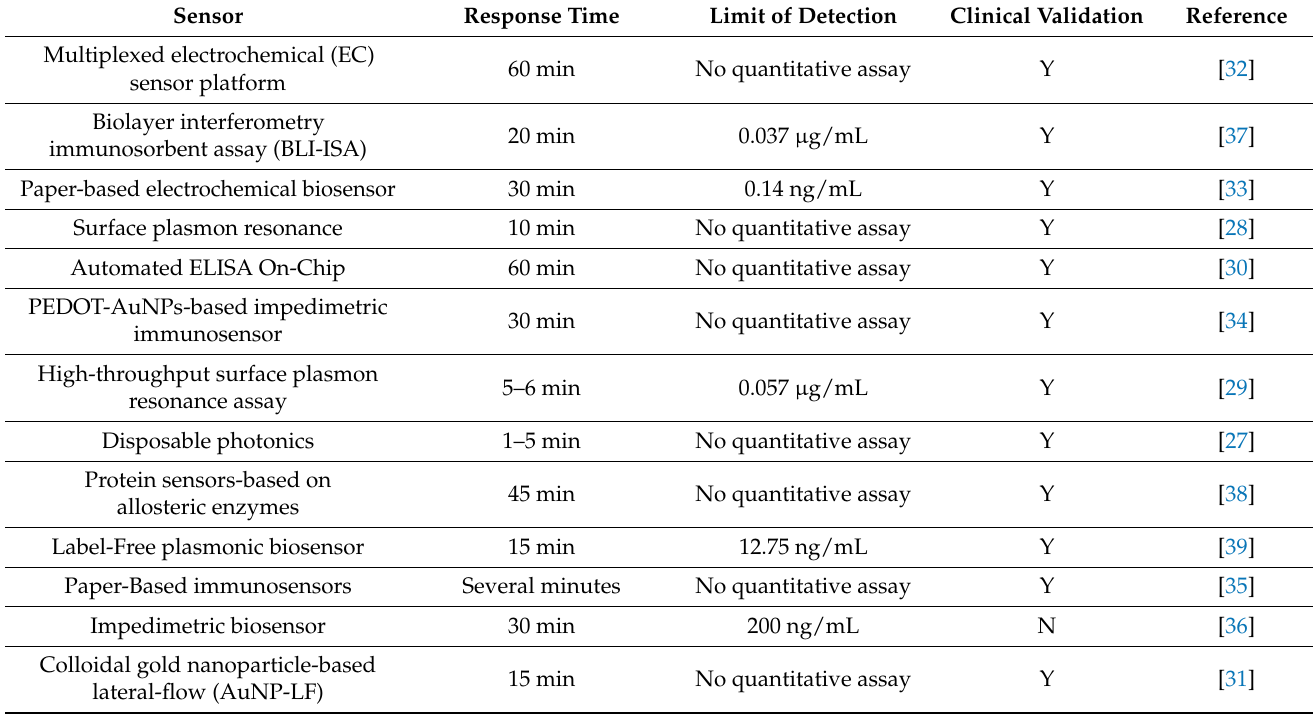
Table 3. Summary of sensors for SARS-CoV-2 antibodies detection. (Y indicates that clinical validation has been performed. N indicates that the system has not been tested against clinical